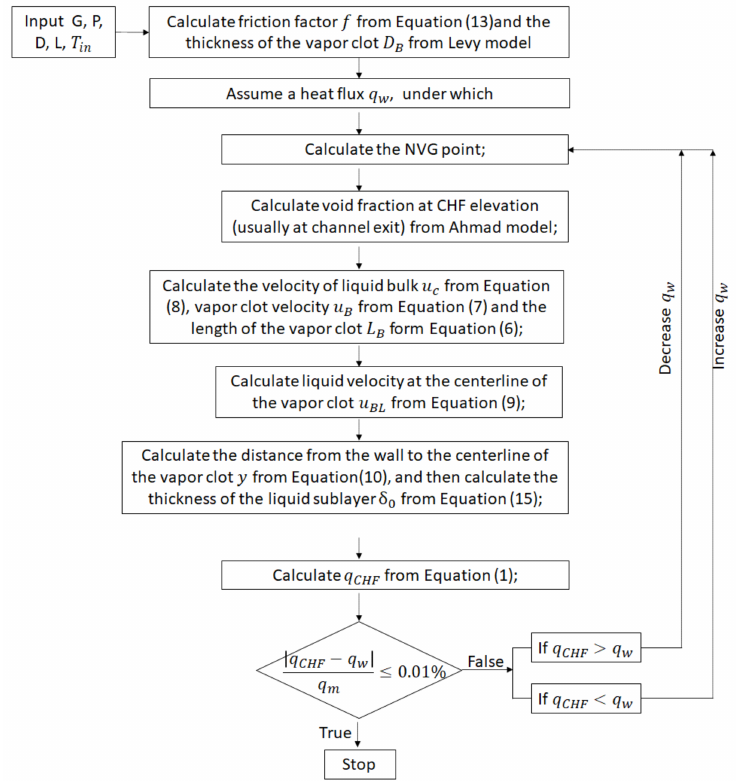
Figure 3. CHF calculation flow